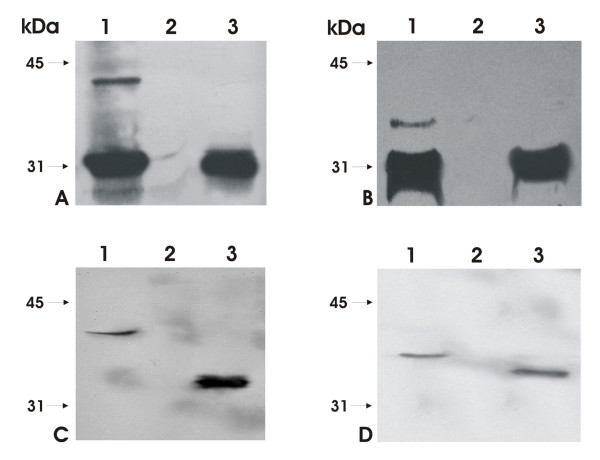
Both uncleaved and cleaved CP protein are produced. Western blotting analysis carried out on protein extracts using a rabbit polyclonal anti-CP antibody (A and B) and a mouse monoclonal anti-6His antibody (C and D). Fifteen micrograms of protein were prepared from mock-inoculated control plants (A2, B2, C2 and D2), plants inoculated with PVX6His2ACP (A3, B3, C3 and D3), plants inoculated with PVX6HisE212ACP (A1 and C1) or with PVX6HisE222ACP (B1 and D1). Standards Molecular weight are shown on the left of each figure (kDa = kiloDaltons).